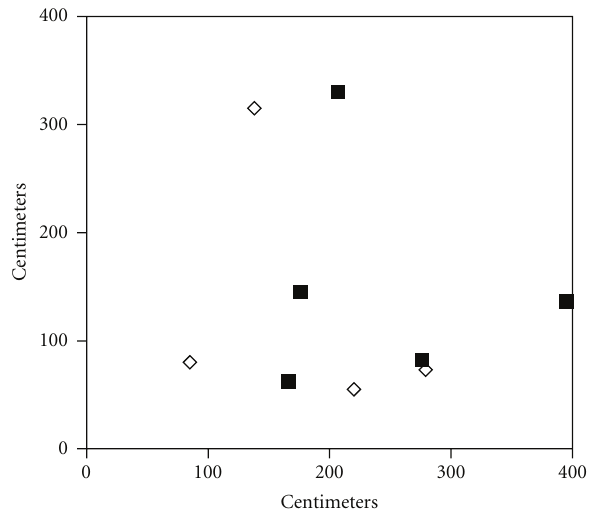
Figure 1: Example litter plot excavated in edge habitat. Each symbol represents an ant nest (defined as consisting of at least two workers and some brood) that was found. Filled squares represent Aphaenogaster rudis nests and open diamonds denote nests of Stenamma diecki . Individual ants walking through the leaf litter were not mapped.